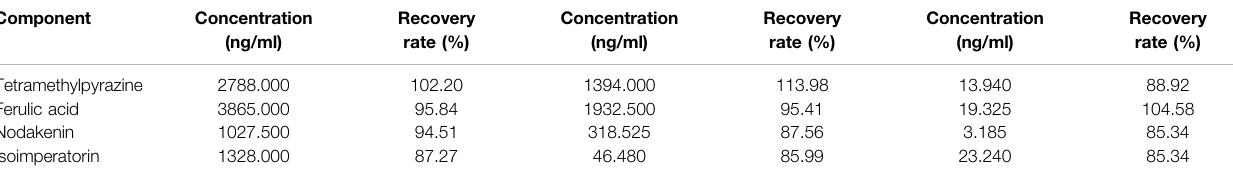
TABLE 8 | Extraction recovery of tetramethylpyrazine, ferulic acid, nodakenin, and isoimperatorin in rabbit plasma ( n = 6). Component